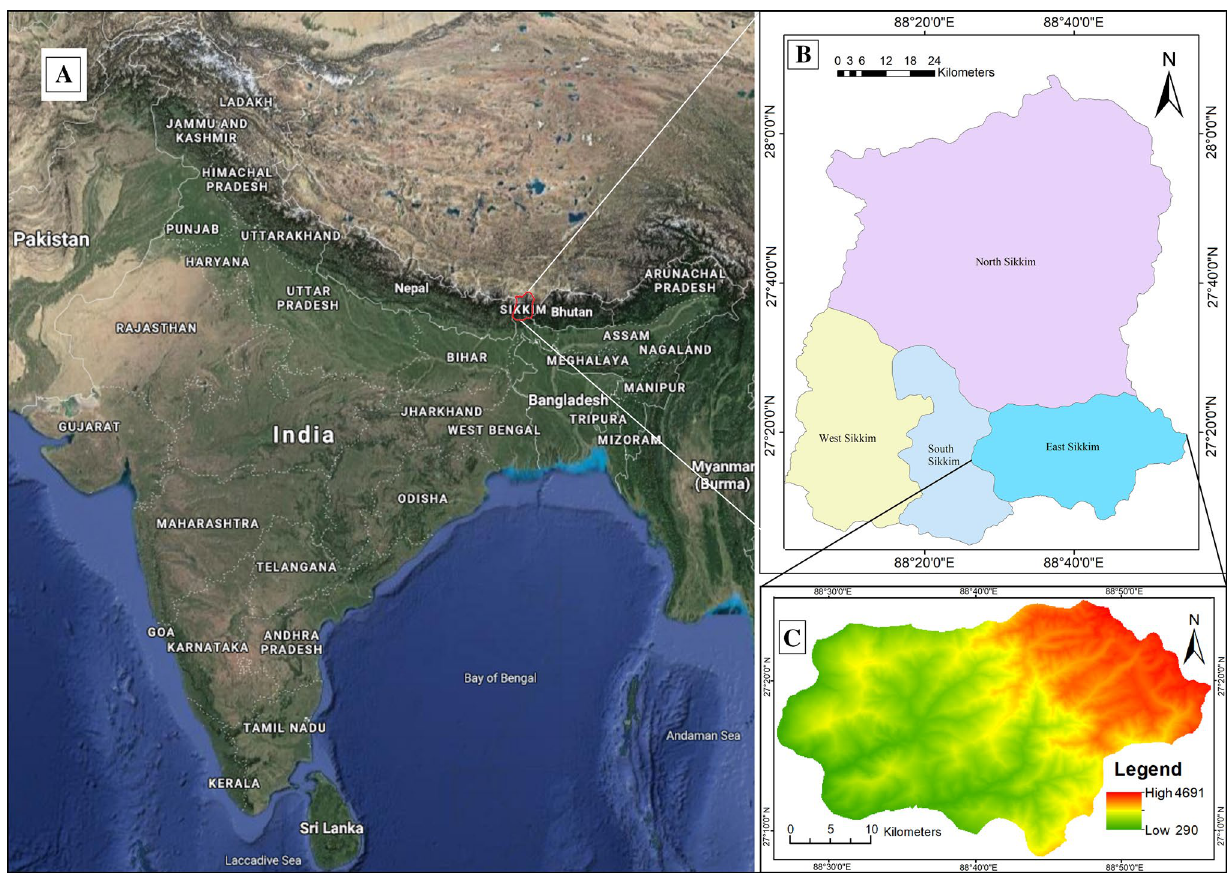
Fig. 1 Maps: A Location of Sikkim and the neighboring states in India which is bordered by China, Bhutan, and Nepal, B Four districts of Sik- kim: East, West, North, and South Sikkim, and C Digital elevation map of the study area. Elevation given in